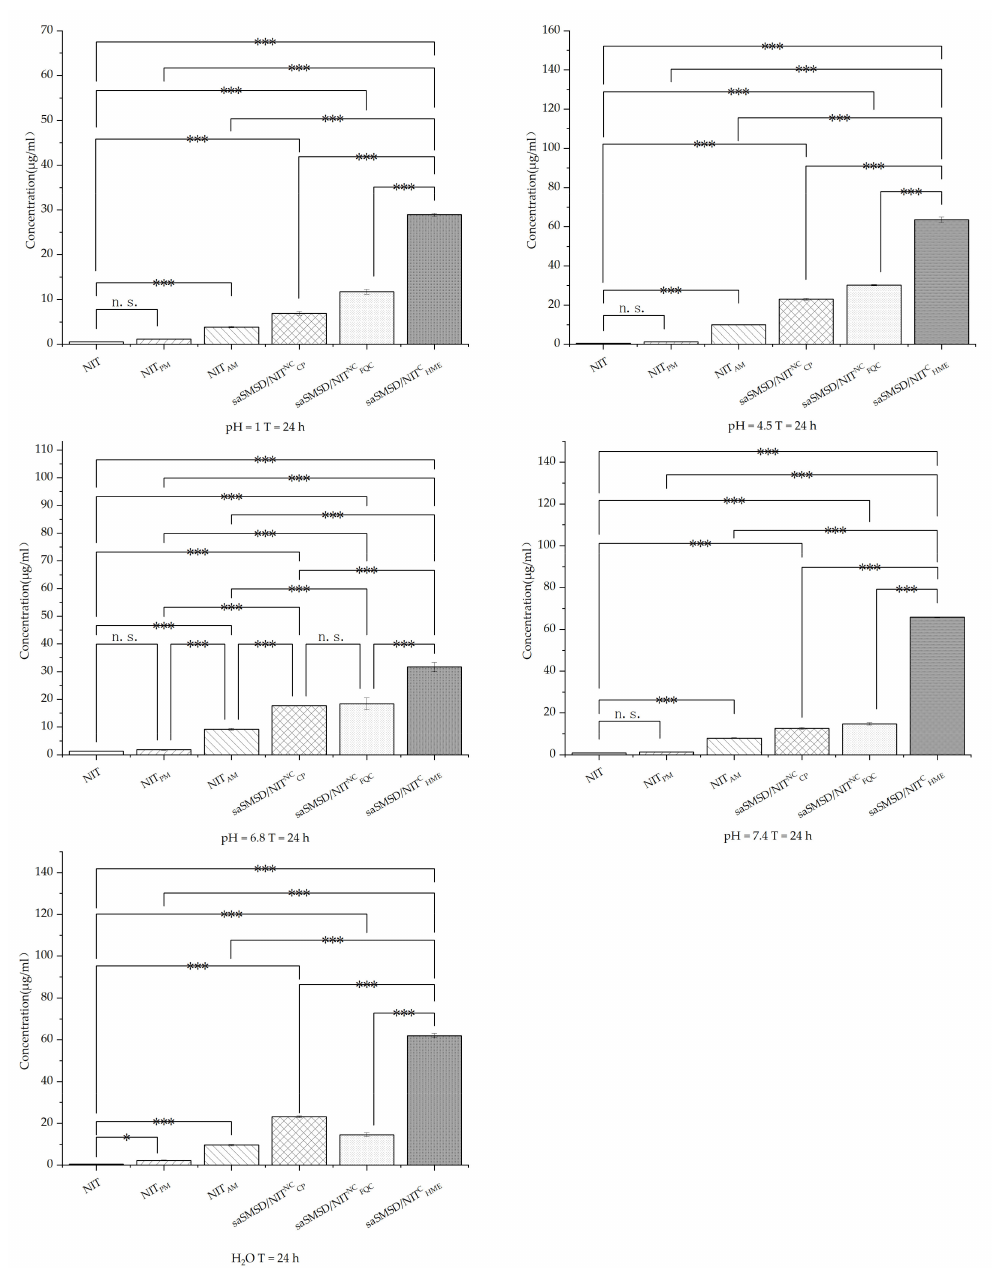
Figure 8. Solubility of samples in different solutions (H 2 O, 0.1 mol/L HCl and PBS (pH 4.5, 6.8, 7.5)) at 24 h; * p < 0.05, *** p < 0.001, n. s., no significant difference. Standard deviation expressed by error bars ( n =